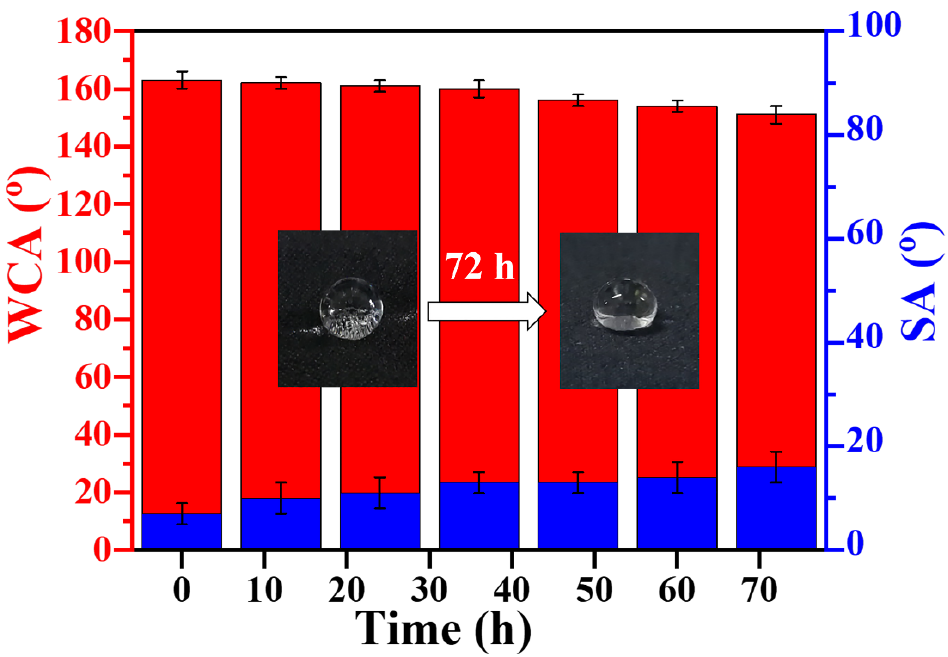
2 -coated fabric.